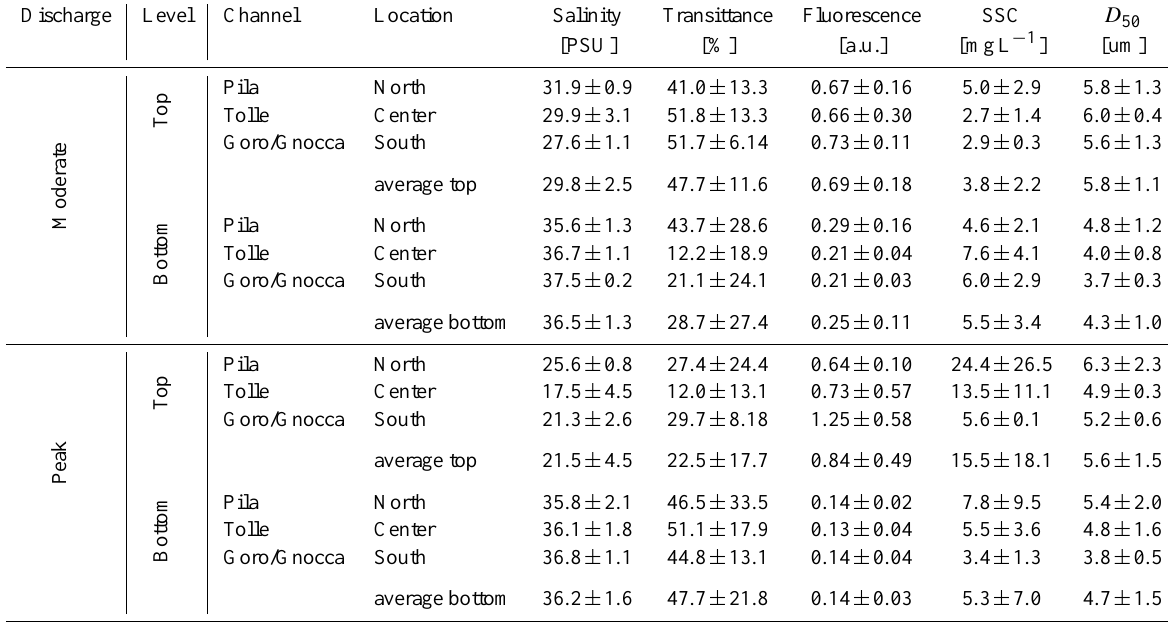
Table 3. Physical parameters for suspended sediment samples collected in the Po prodelta before and during the peak discharge.